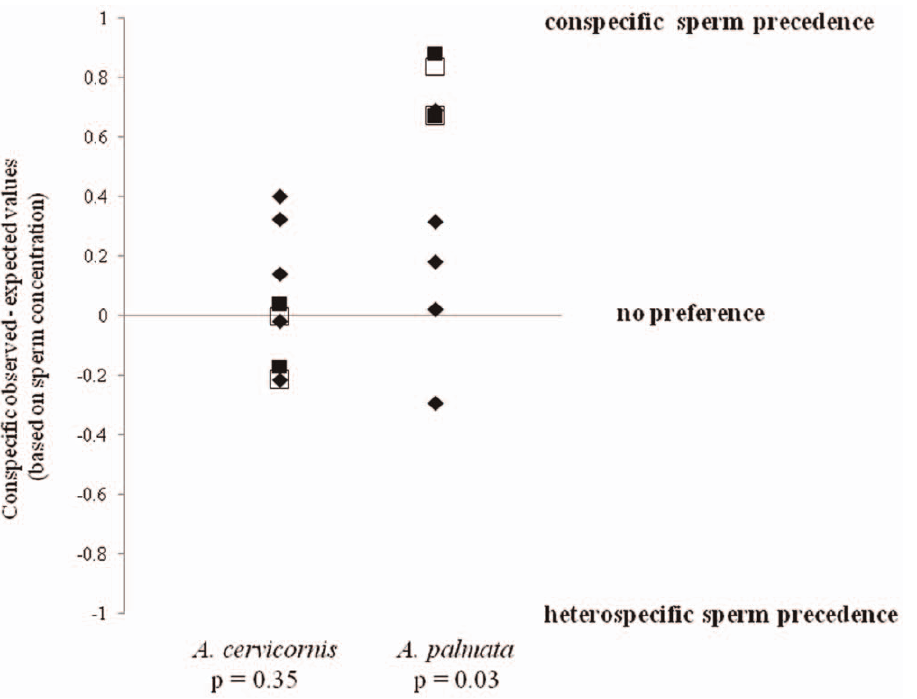
Figure 5. Choice crosses. Points denote the difference in the observed and the expected number of conspecific larvae sired for choice crosses. Expected values were calculated based on sperm concentration. Values of 1 would signify 100% of larvae sired by conspecific sperm, 2 1 would signify 100% of larvae sired by heterospecific sperm. Positive values denote conspecific sperm precedence (CSP), negative values represent heterospecific sperm precedence (HSP), and 0 represents no preference. Closed symbols represent competitive trials when gametes were fresh. Squares represent the four crosses where competitive trials were conducted when gametes were fresh (closed squares) and gametes had aged four hours (open squares).